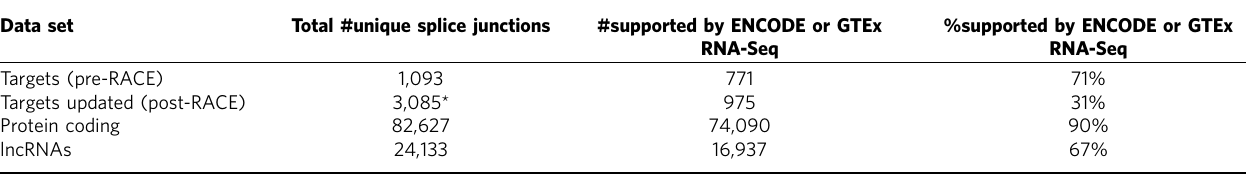
Table 4 | Proportion of annotated splice junctions in pre- and post-RACE-Seq targets supported by short-read ENCODE or GTEx RNA-Seq